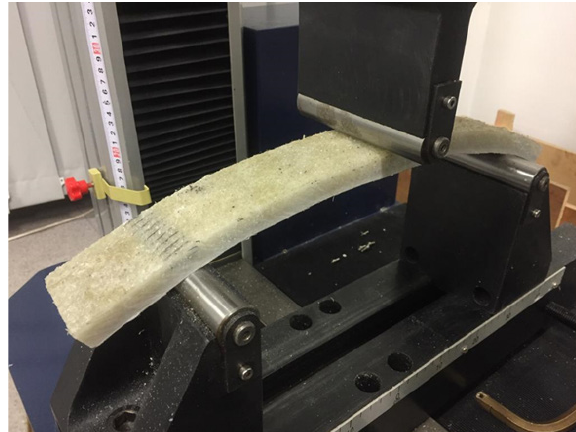
Figure 11: Laboratory test of a liner – diameter 500 mm.